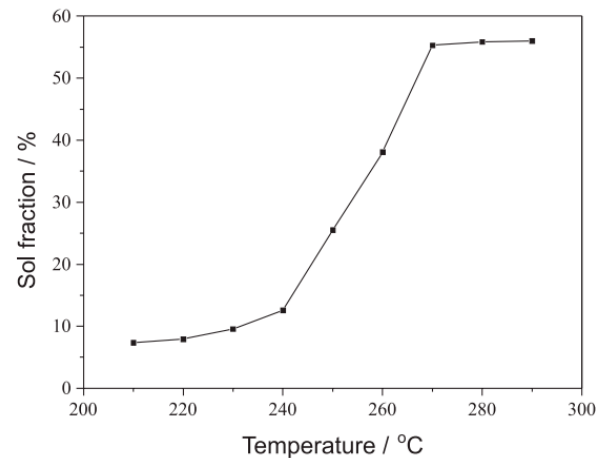
Figure 18. Effect of temperature on the sol fraction of regenerated sidewall rubber obtained from a passenger car tire (regeneration reaction conditions are 8 MPa for 60 min) (reproduced with permission from [110]).